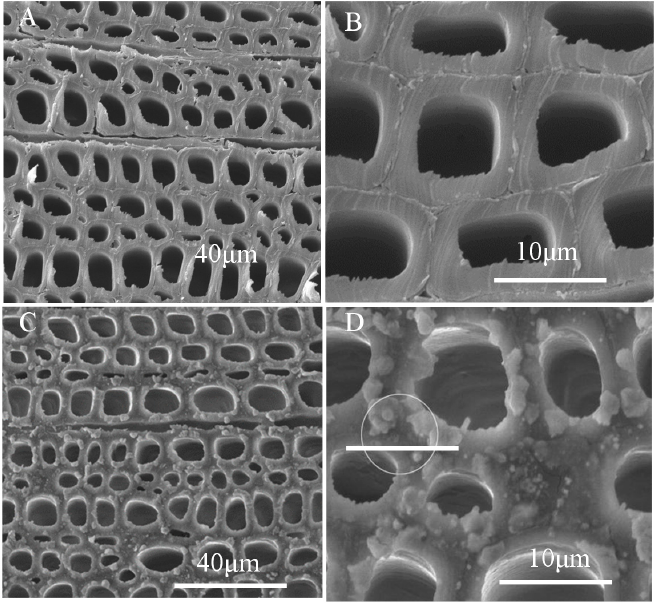
Figure 8. The SEM images of wood samples on cross section: ( A – B ) untreated wood; ( C – D ) PDMS@wood.